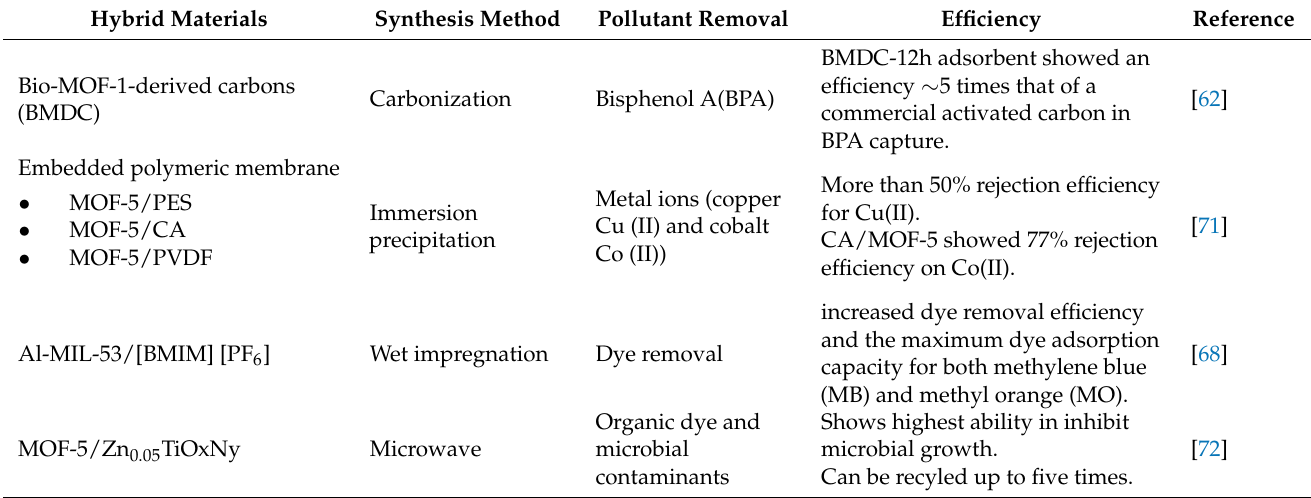
Table 3. Summary of wastewater treatment applications used hybrid materials as